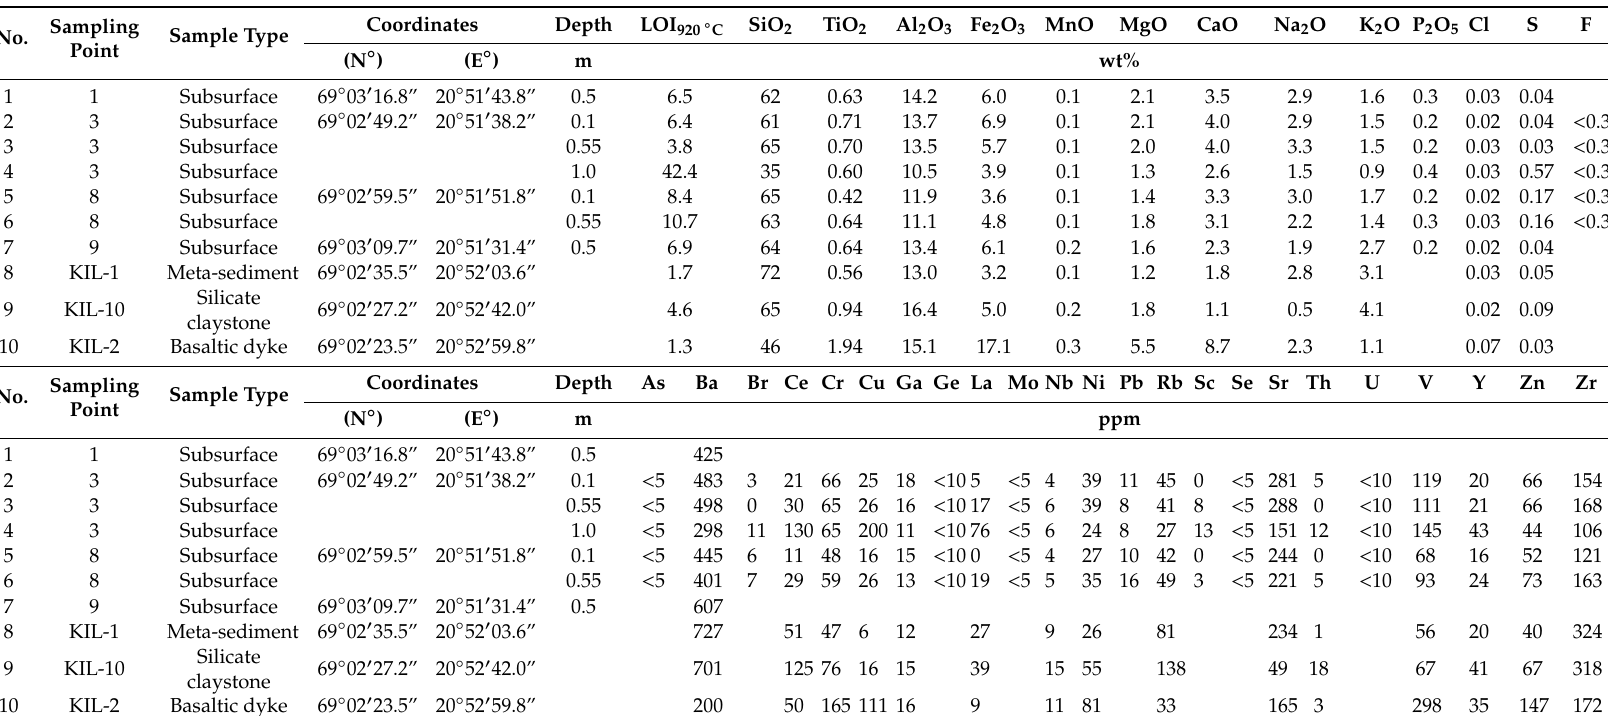
Table 1. Chemical composition of rock and surface samples in the Lake Saana